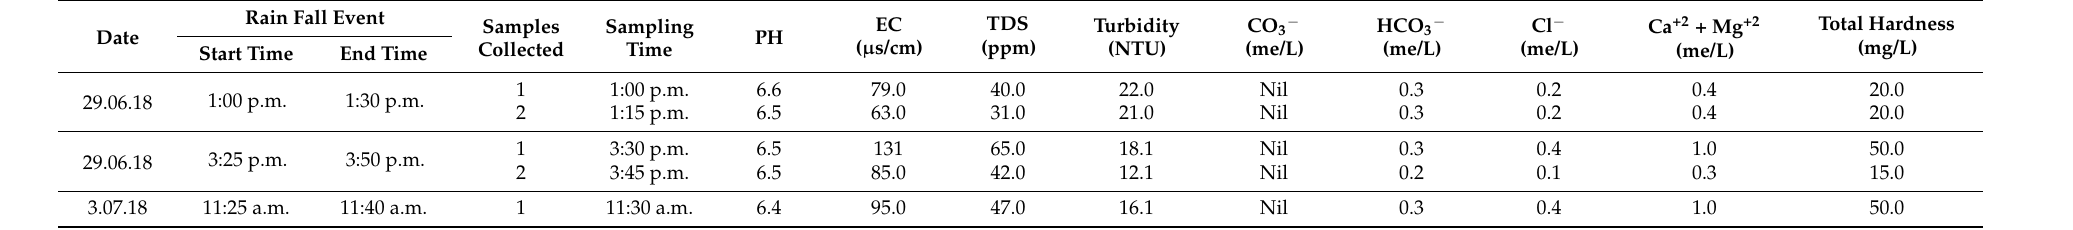
Table A4. Rooftop rain samples collected from Site